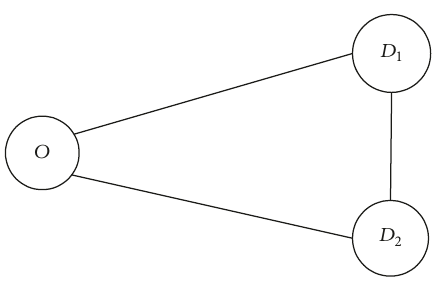
Figure 1: Travel routes of carpooling